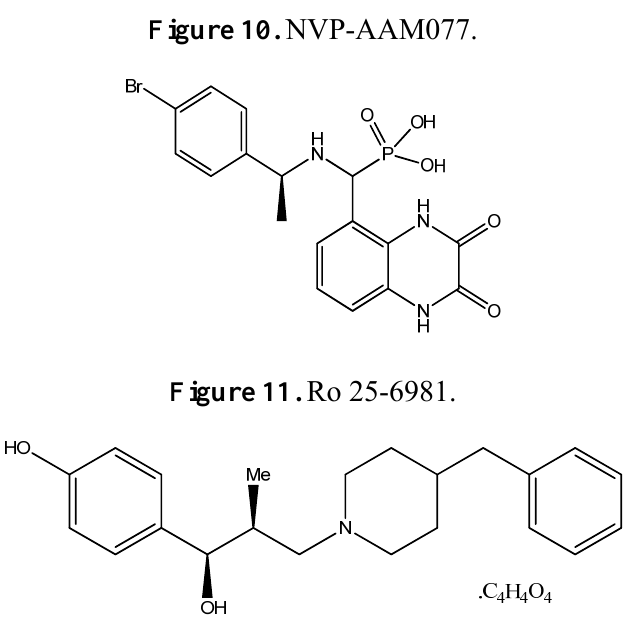
Figure 10. NVP-AAM077.